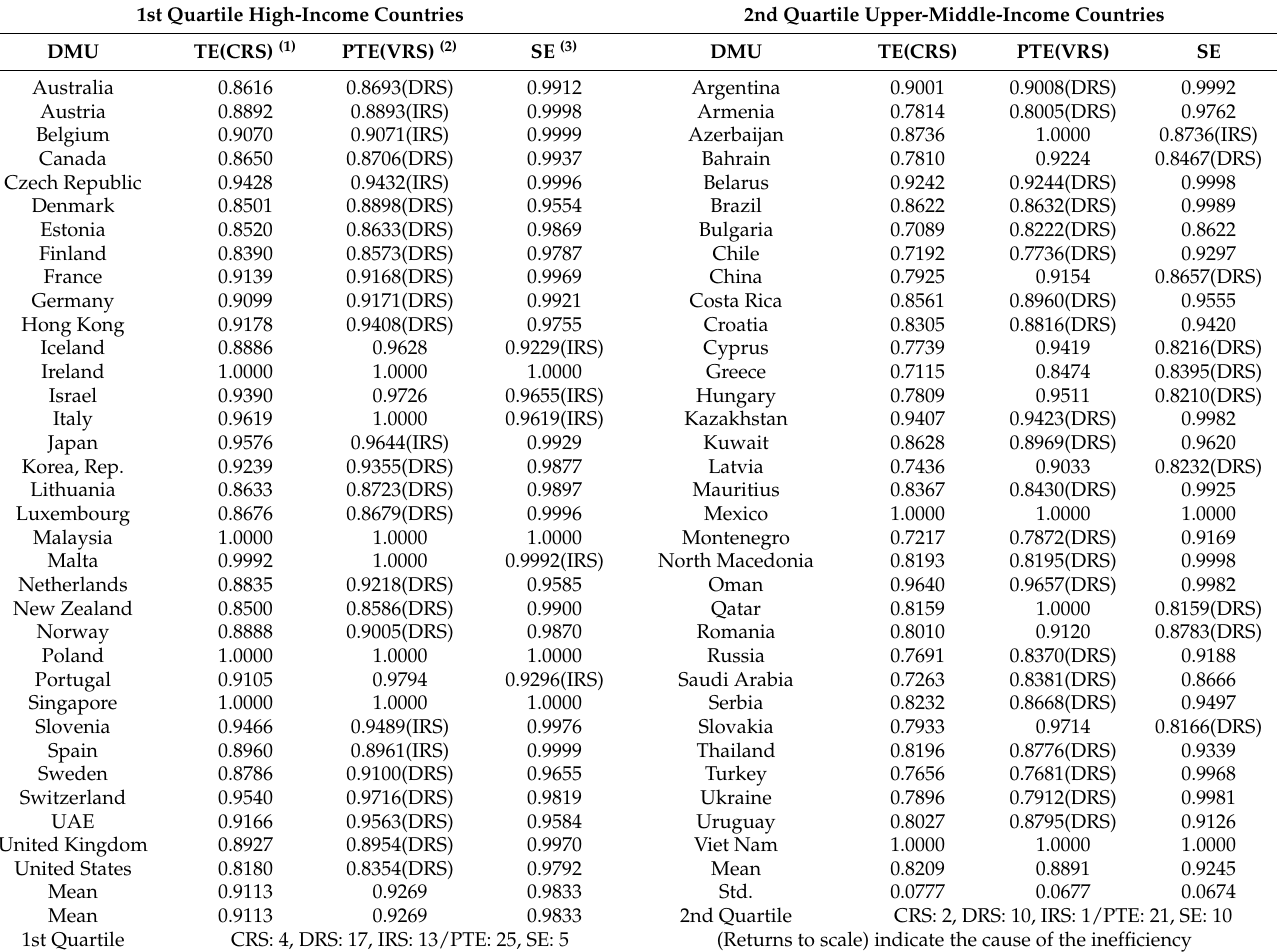
Table 4. Efficiency analysis results of 1st quartile high-income countries and 2nd quartile upper- middle-income